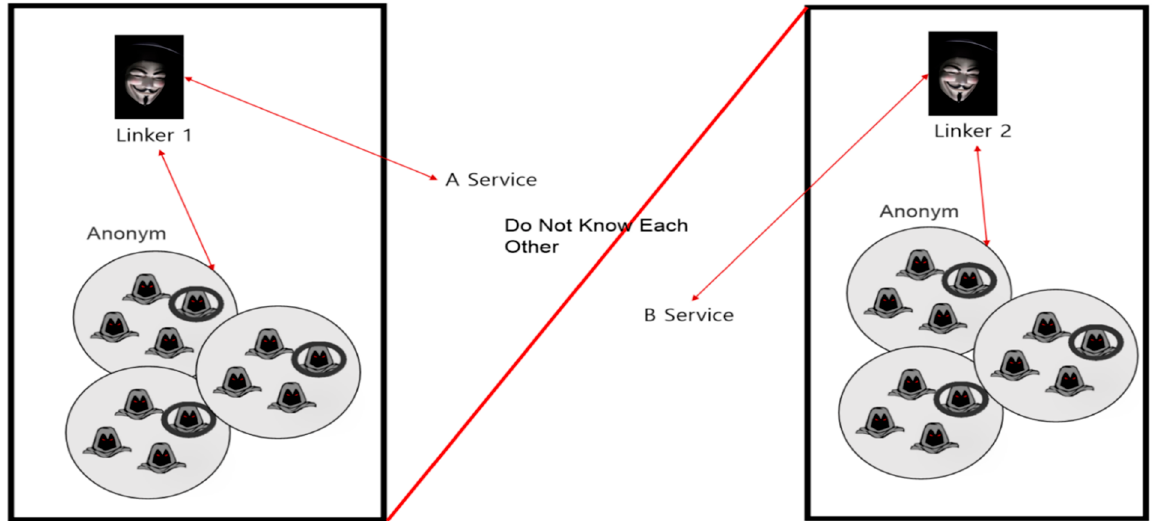
Figure 6. The group signature-based other scenario.